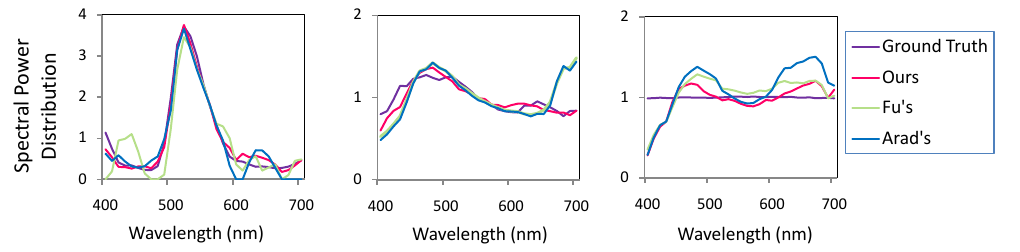
( b ) Comparison of the reconstructed spectra at position a (left), b (middle), c (right) using Fu’s, Arad’s, and our method. Figure 8. The comparison of reconstruction accuracy of the three MSFAs (see Figure 7).